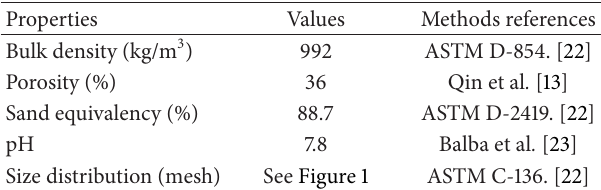
Table 1: Physicochemical properties of sandy